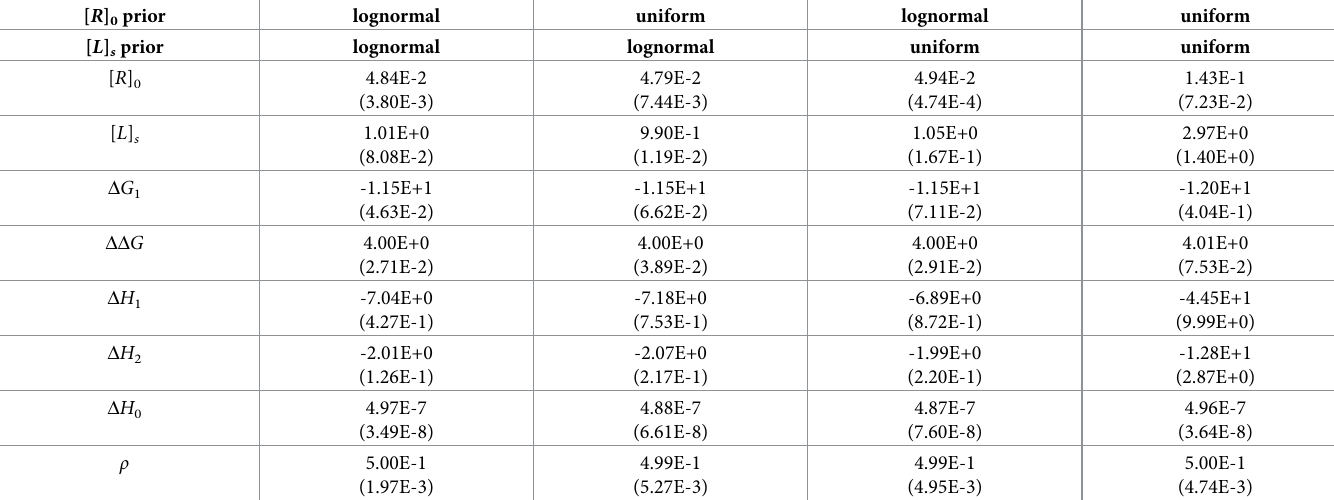
Table 1. Mean and standard deviation (in parentheses) of the Bayesian posterior with four concentration priors, based on the 50 simulations from the EM model.